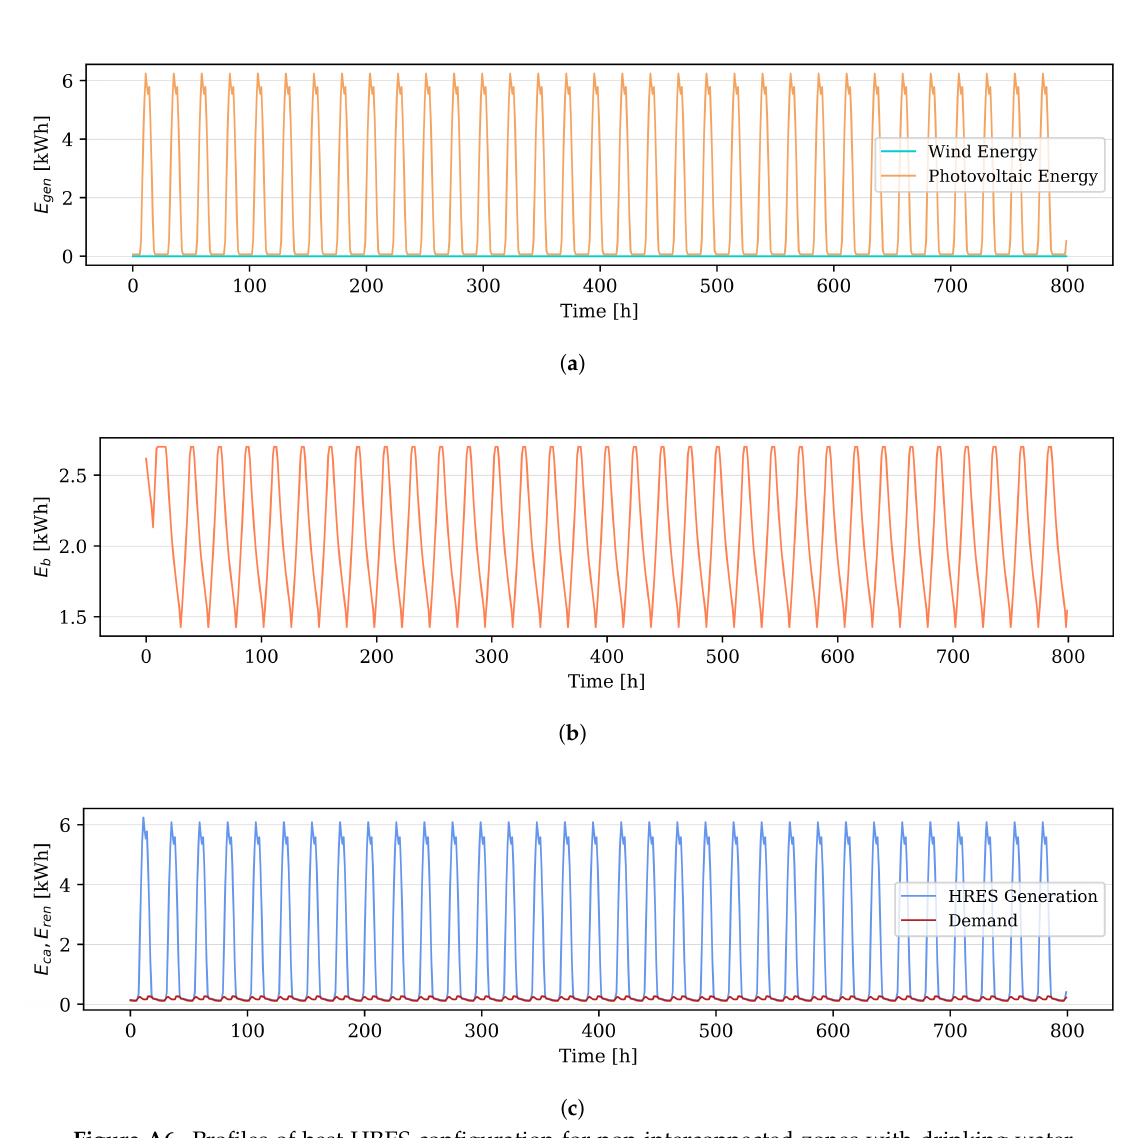
Figure A6. Profiles of best HRES configuration for non-interconnected zones with drinking water consumption (4.27 kW-h/day) obtained by multi-objective function with LCOE , N pv ,1 = 6, N pv ,2 = 6, N pv ,3 = 15, N b = 2. ( a ) Total renewable energy generation. ( b ) Storage system state. ( c ) HRES generation vs.